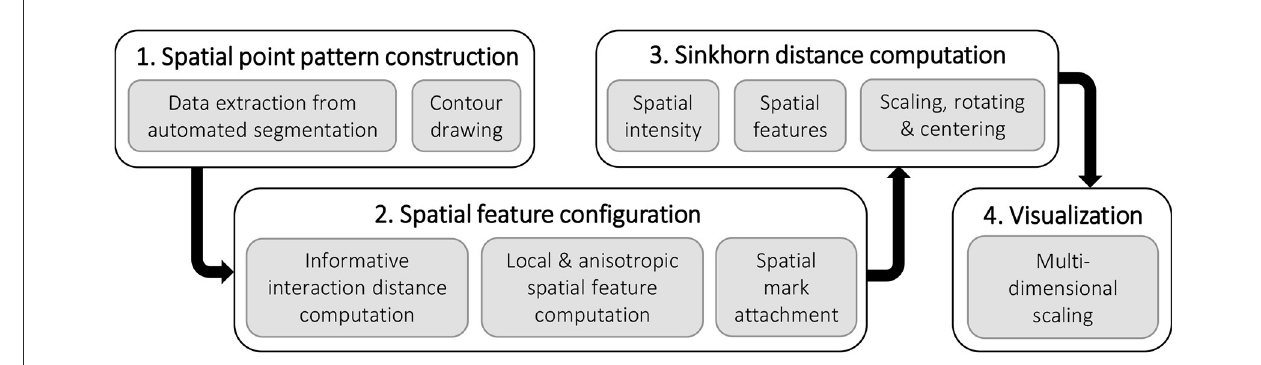
FIGURE1 The pipeline for the quantitative analysis of the spatial arrangement of axons in the peripheral nerve